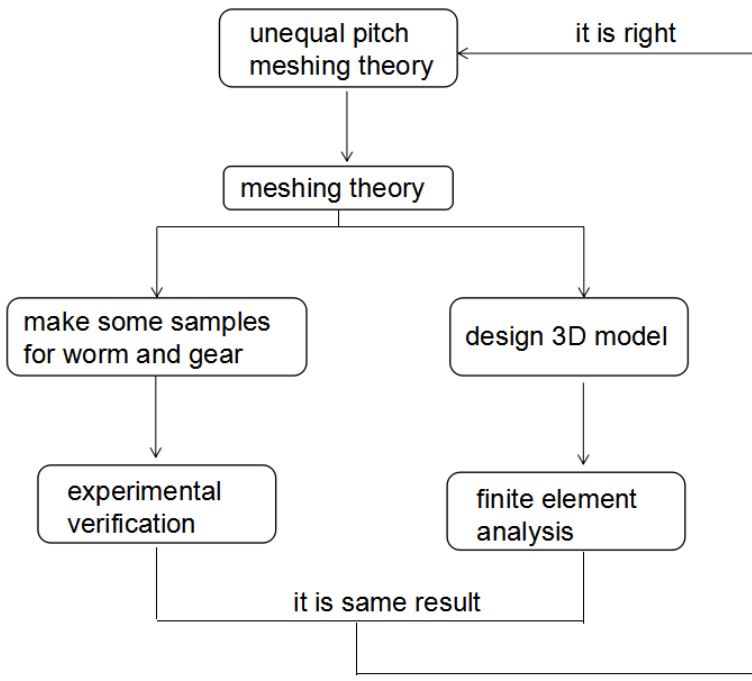
Figure 7. The schematic diagram of the research flow.